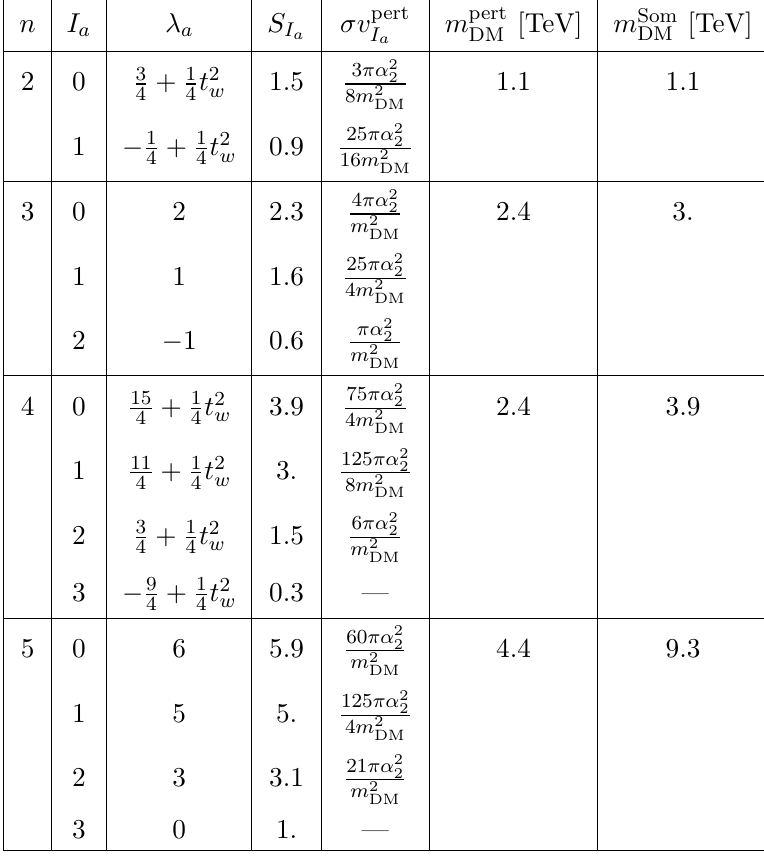
| ( (cid:11) I + (cid:11) 0 ) =(cid:11) 2 couplings and, using (cid:27)v pert I a a (cid:0) in the 2-blet, 4-plet cases, one obtains m Som for the dark DM g;gg 0 is obtained DM